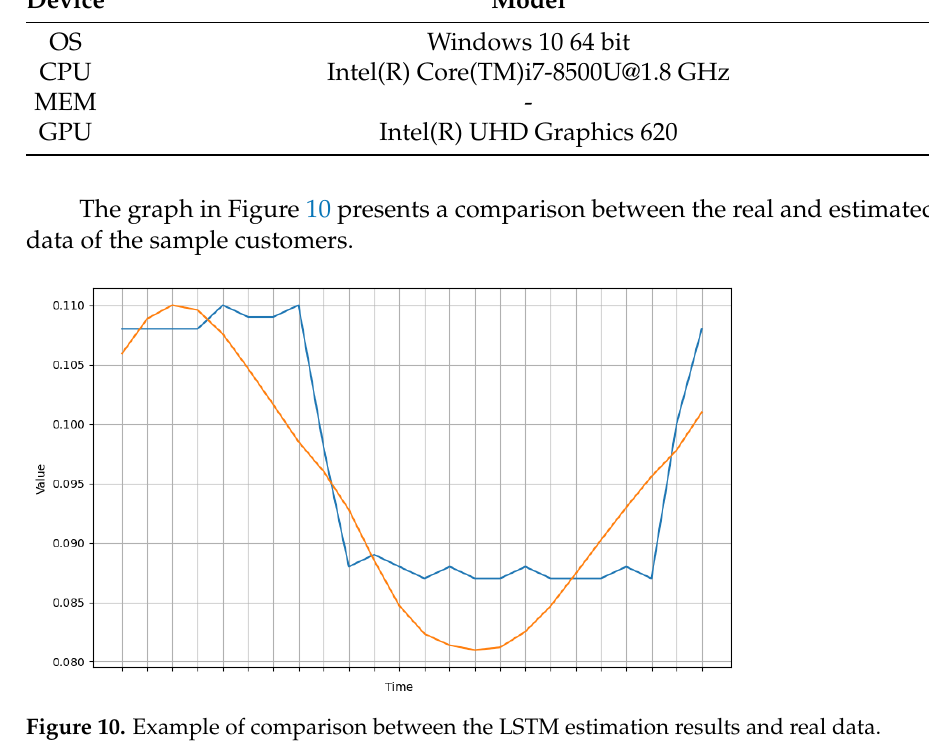
Figure 10. Example of comparison between the LSTM estimation results and real